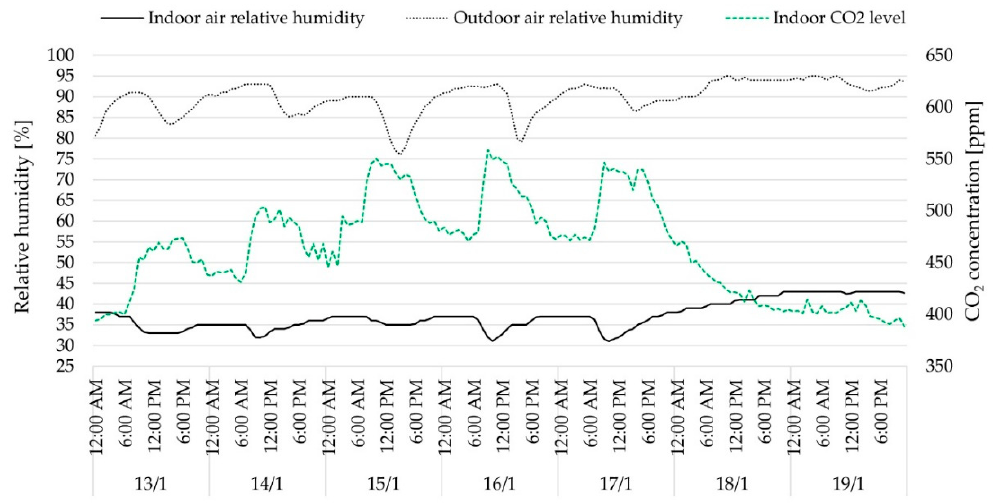
Figure 11. Monitored indoor air relative humidity and CO 2 concentration level vs. outdoor air relative humidity for the coldest week in winter.